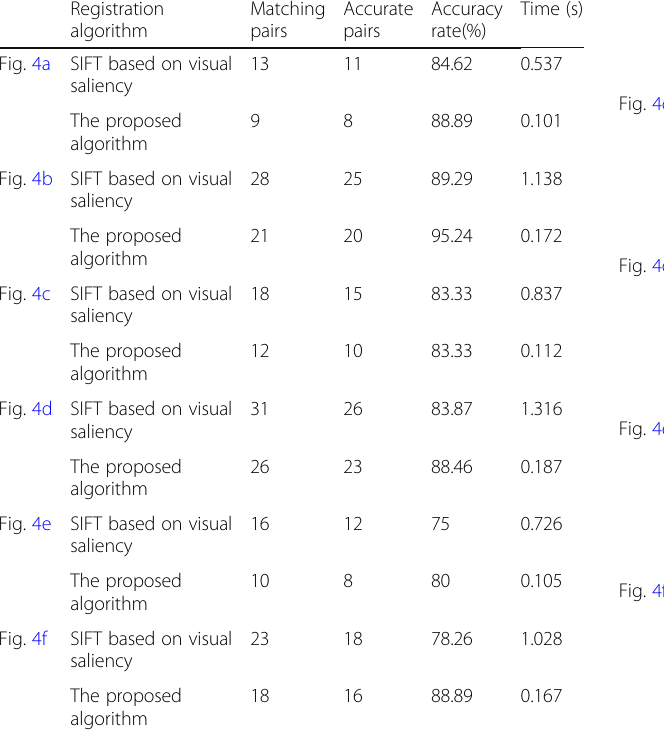
Table 1 The registration result between PCA-SIFT algorithm and SIFTs based on visual